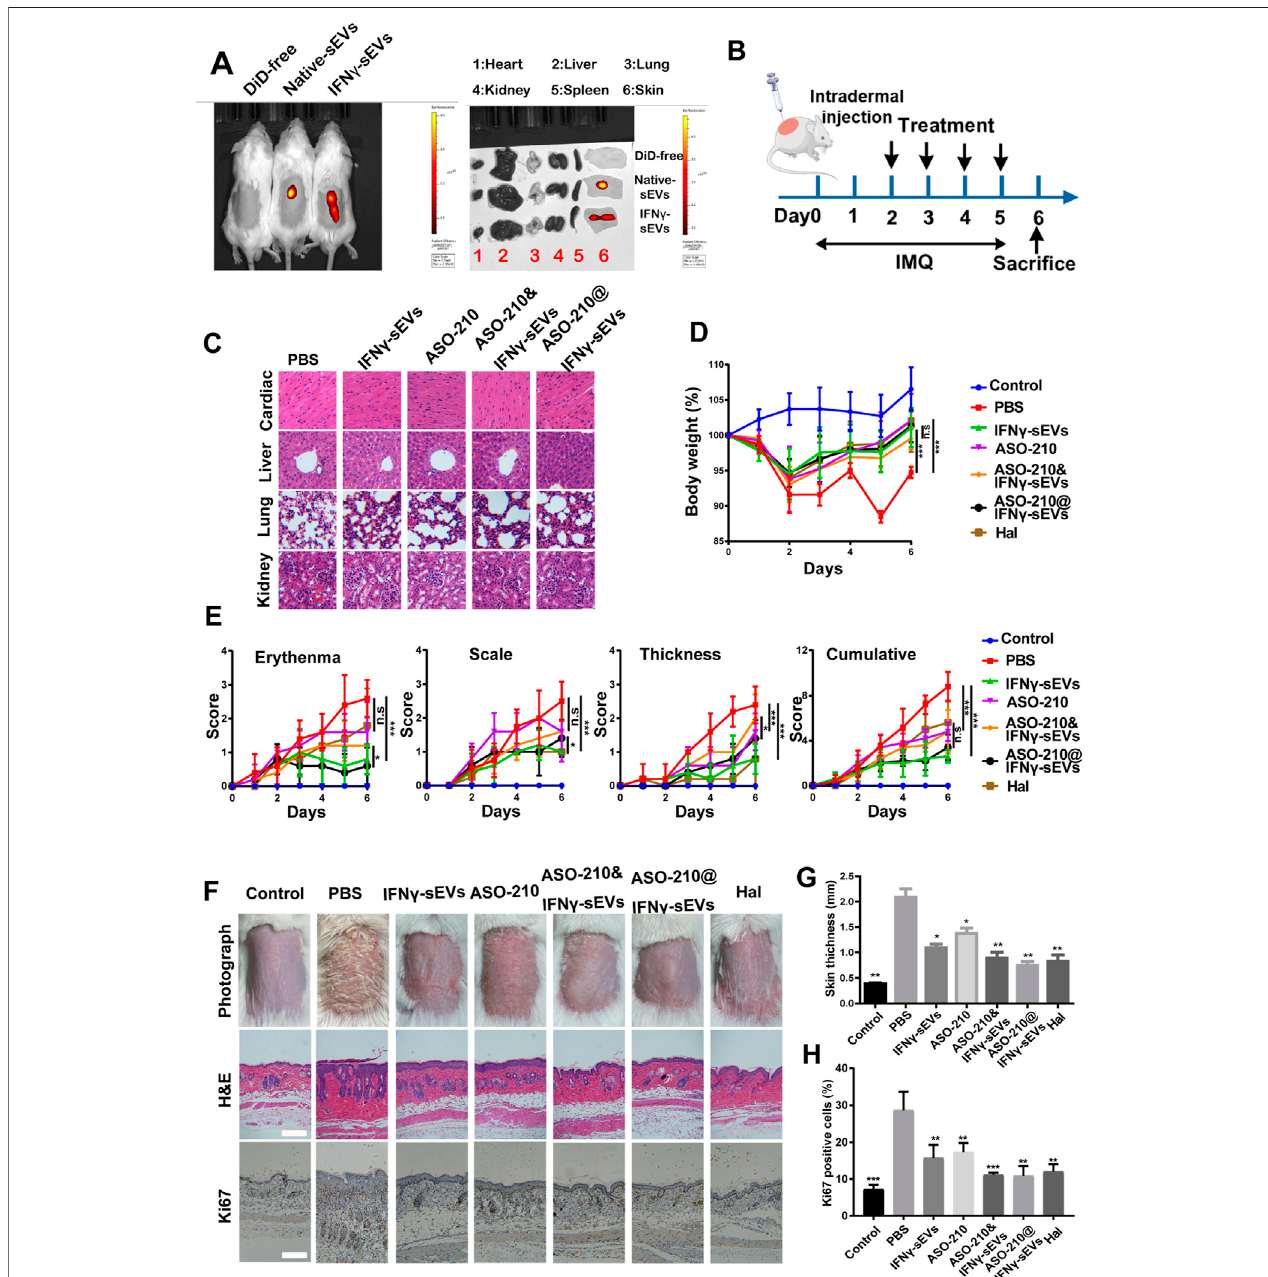
FIGURE 3 | Intradermal administration of IFN γ -sEVs loading with ASO-210 ameliorates the pathological phenotype of IMQ-induced psoriasis-like mice. (A) In vivo distribution of native sEVs and IFN γ -sEVs in IMQ-induced psoriasis-like mice. (B) Schematic diagram for intradermal administration of IFN γ -sEVs, ASO-210, ASO- 210&IFN γ -sEVs, and ASO-210@IFN γ -sEVs on day 2, 3, 4, and 5 during the application of IMQ in BALB/c mice. (C) Safety evaluation of IFN- γ and ASO-210 Scale bar: 40 μ m. (D) Thebodyweightofthemiceindifferentgroups(n=5). (E) Thickness,erythema,scales,and accumulativescoreofdifferentgroupswererecordeddaily fromday0today6(n=5). (F) Representativeskinsurfacemorphology,H&EstainingandKi67immunohistochemistryoftheskinlesionsofmiceineach grouponday7. Scale bar: 100 μ m. (G) Skin thickness was measured using Image Pro Plus on the day 6, n = 4/5. Error bar, mean ± SD. n.s represents no signi fi cance, * p < 0.5, ** p < 0.01,and*** p < 0.001. (H) Ki67 + cellpercentageinpsoriaticskinlesionwascalculatedbyImageJonday6,n=4/5.Errorbar,mean±SD.n.srepresentsnosigni fi cance, * p < 0.5, ** p < 0.01, *** p < 0.001.